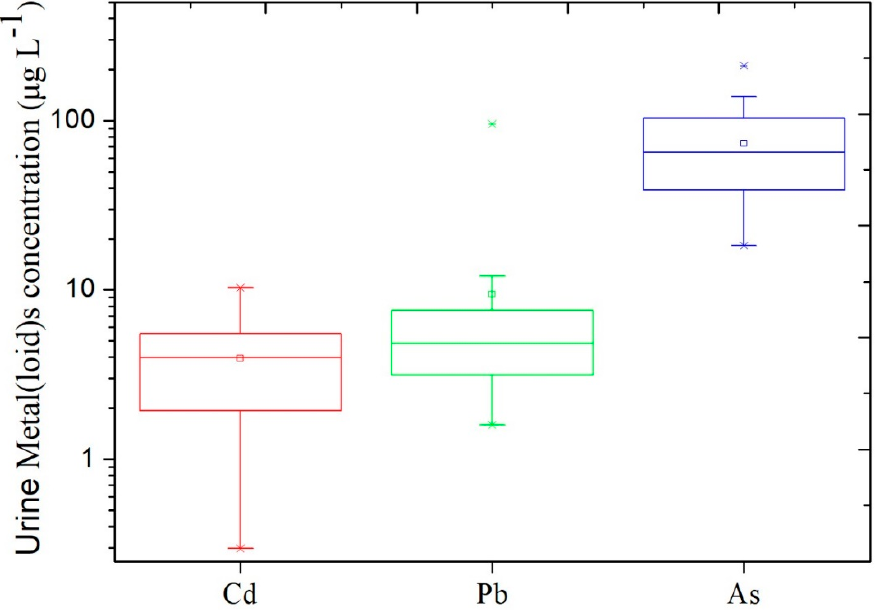
Figure 5. Metal(loid) concentrations in urine samples collected from the local residents ( n = 30).